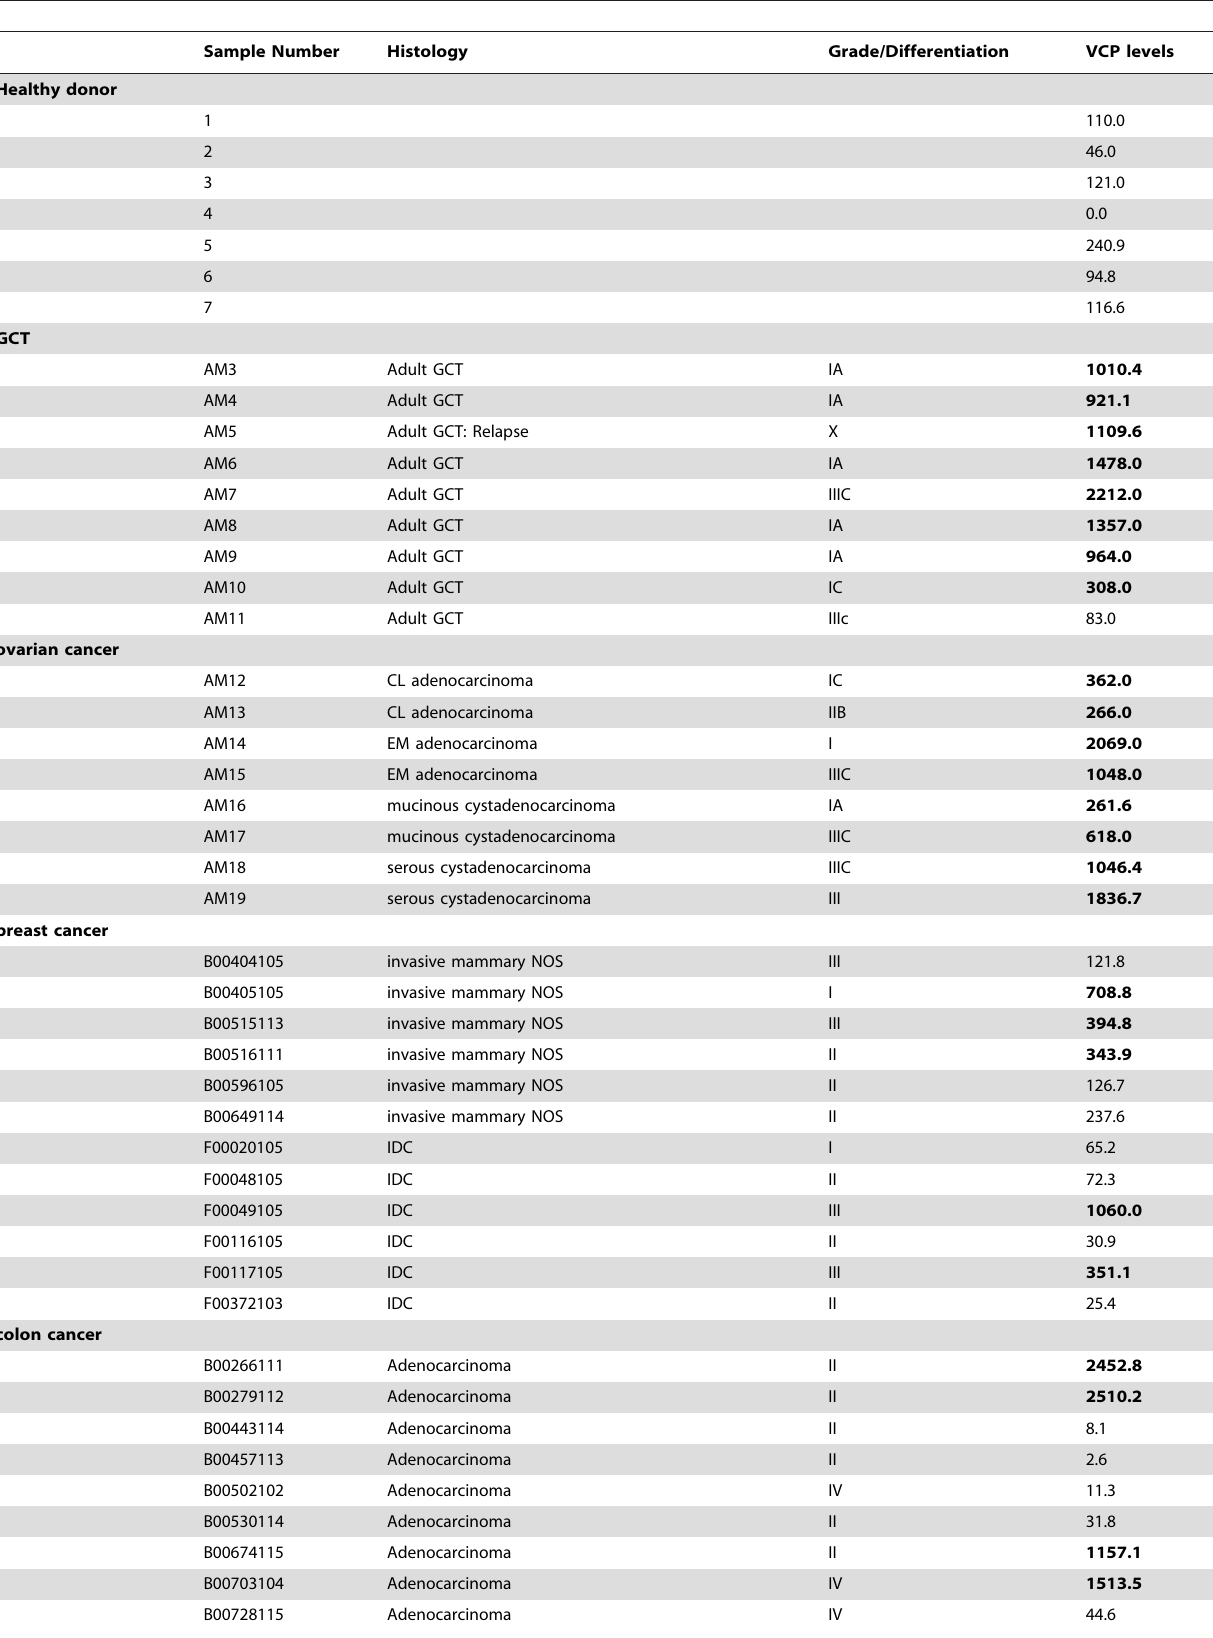
Table 3. Tumor clinical features and VCP serum level in tested cancer